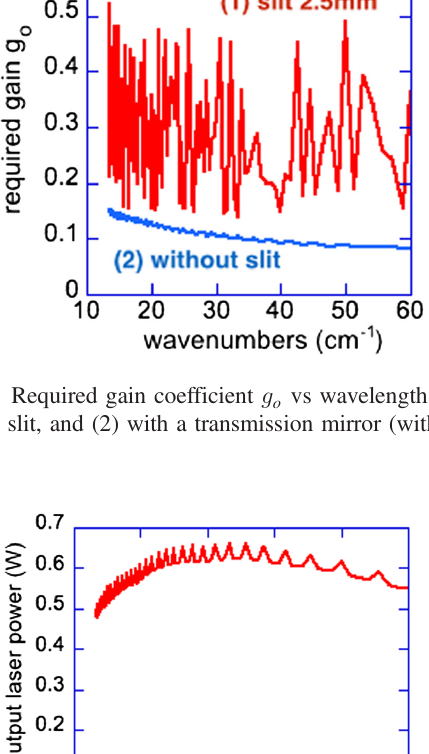
FIG. 30. Simulation of the output laser power of FLARE, without extraction slit (extraction by mirror